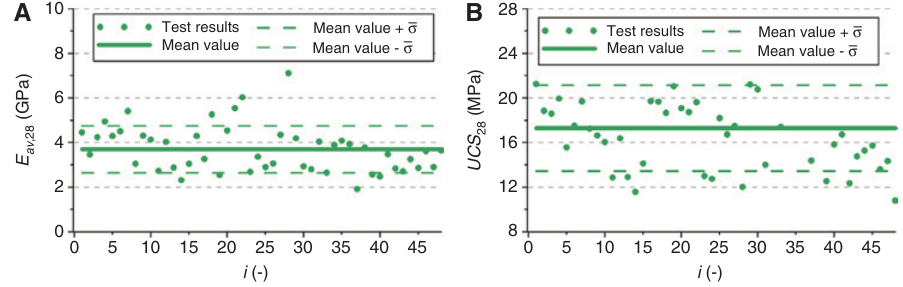
Figure 15: The results of successive uniaxial compression tests for mortar samples ( D = 28 mm). (A) variation of Young modulus and (B) variation of UCS .